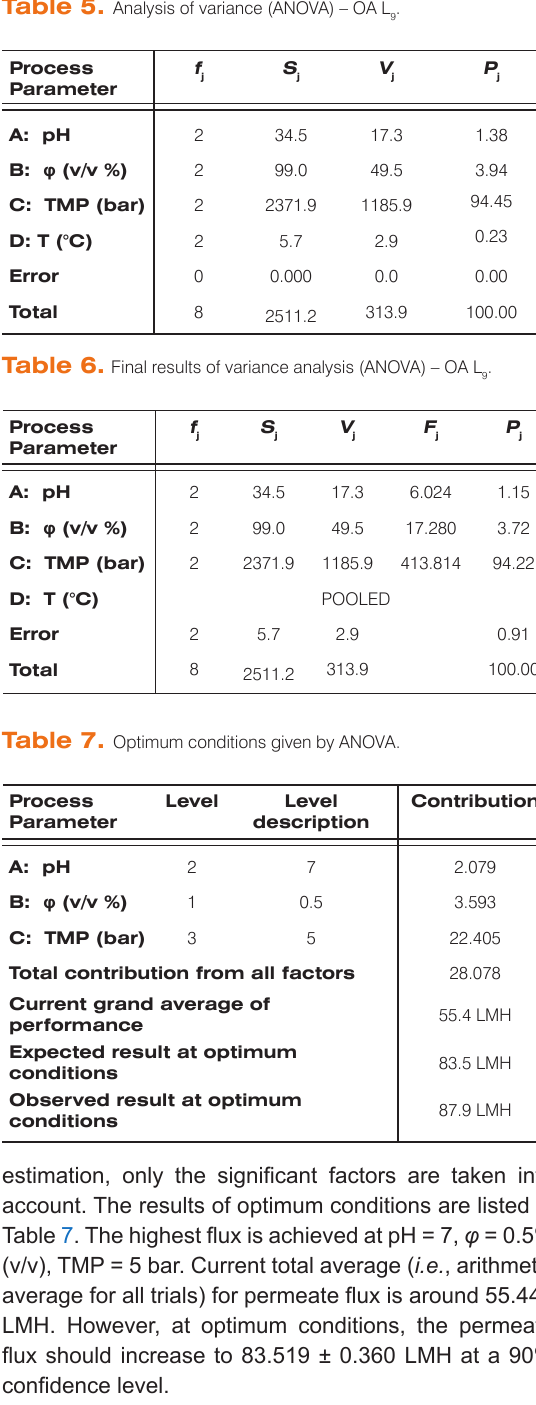
Table 5. Analysis of variance (ANOVA) – OA L